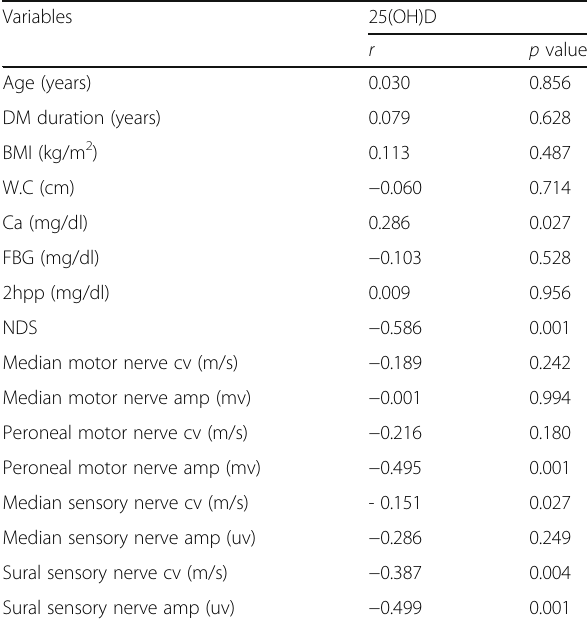
Table 3 Correlation of 25(OH) D level with the laboratory and neurophysiological studies in T2DM groups Variables